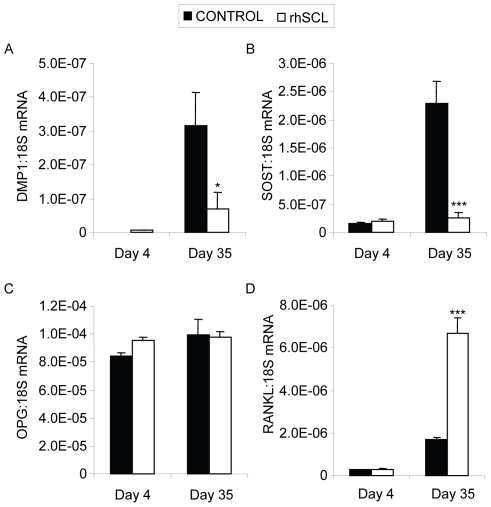
Effects on gene expression of continuous exposure of mineralizing NHBC cultures to rhSCL.NHBC were cultured under mineralizing conditions for up to 35 days in the absence or presence of rhSCL at 50 ng/ml. Media were replenished every 3–4 days. At the time points indicated, total RNA was prepared and real-time RT-PCR performed to determine mRNA expression of A) DMP1, B) SOST, C) OPG and D) RANKL. Data shown are means of triplicate reactions ± SD normalized to expression of 18S mRNA. Significant differences to untreated control are indicated by * p<0.05 and *** p<0.001. Similar results were obtained from 3 independent experiments using NHBC from different donors.